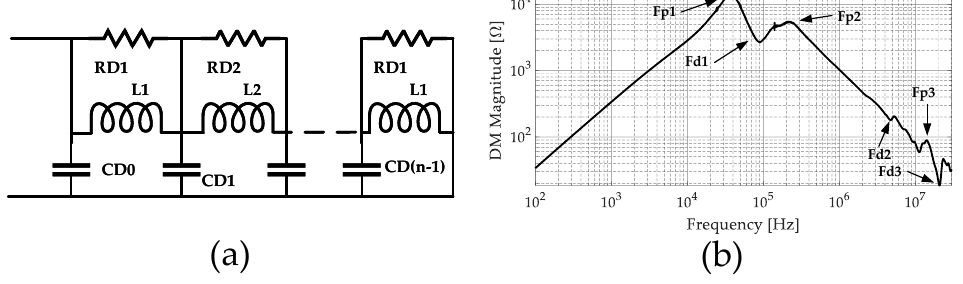
Figure 8. Measurement-based modeling of an IM. ( a ) Typical single-phase equivalence for DM impedance; ( b ) DM